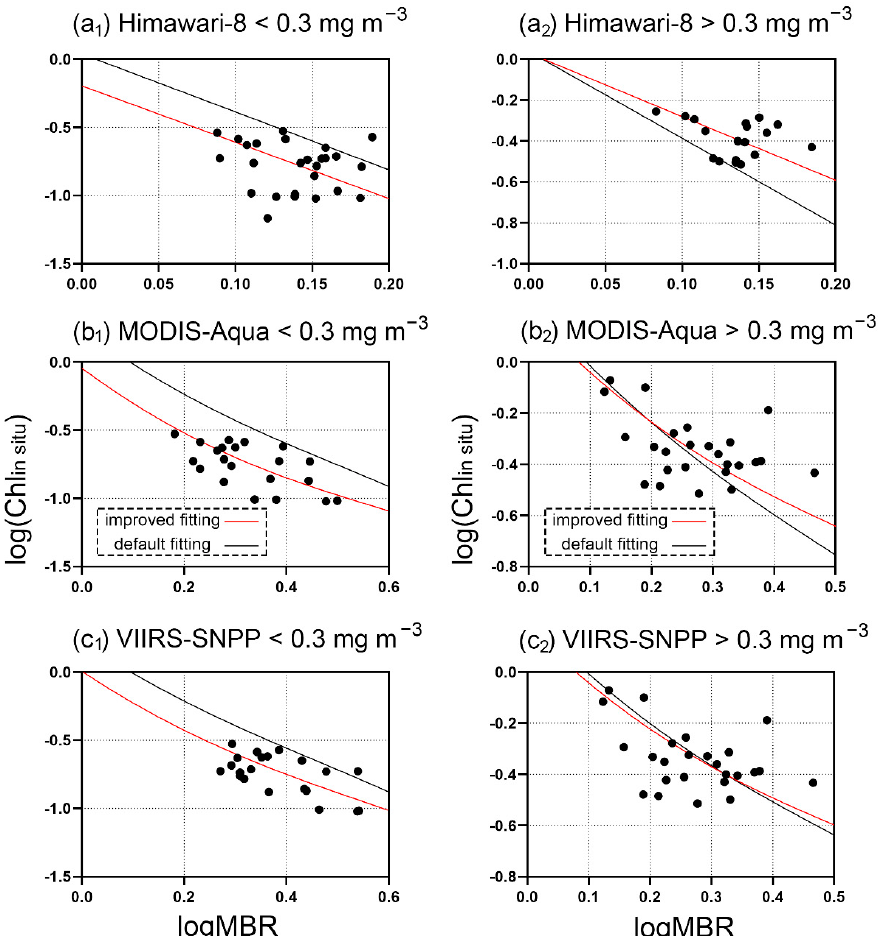
Figure 6. The default algorithm fitting line (black line) and optimized fitting line (red line) for each sensor. ( a 1 – c 1 ) are the fitting lines of each sensor when the in situ Chl-a concentration > 0.3 mg m − 3 . The lines of the in situ Chl-a concentration > 0.3 mg m − 3 group are shown in ( a 2 – c 2 ). For the Chl in situ > 0.3 mg m − 3 group, Himawari-8 has 18 matched data points, MODIS- Aqua has 25 matched data points, and VIIRS-SNPP has 24 matched data points. The ad- justed results for the polynomials are shown in Figure 6(a 2 –c 2 ). The adjustment of Himawari-8 is obvious, and the red line is above the black line. For MODIS-Aqua and VIIRS-SNPP, the trend of the line is mildly adjusted. The new coefficients of the Chl-a algorithms are shown in Table 4. Each sensor has two algorithms for the different data groups. To avoid overfitting, the coefficients a 3 and a 4 of MODIS-Aqua and VIIRS-SNPP in the Chl in situ > 0.3 mg m − 3 group are the default